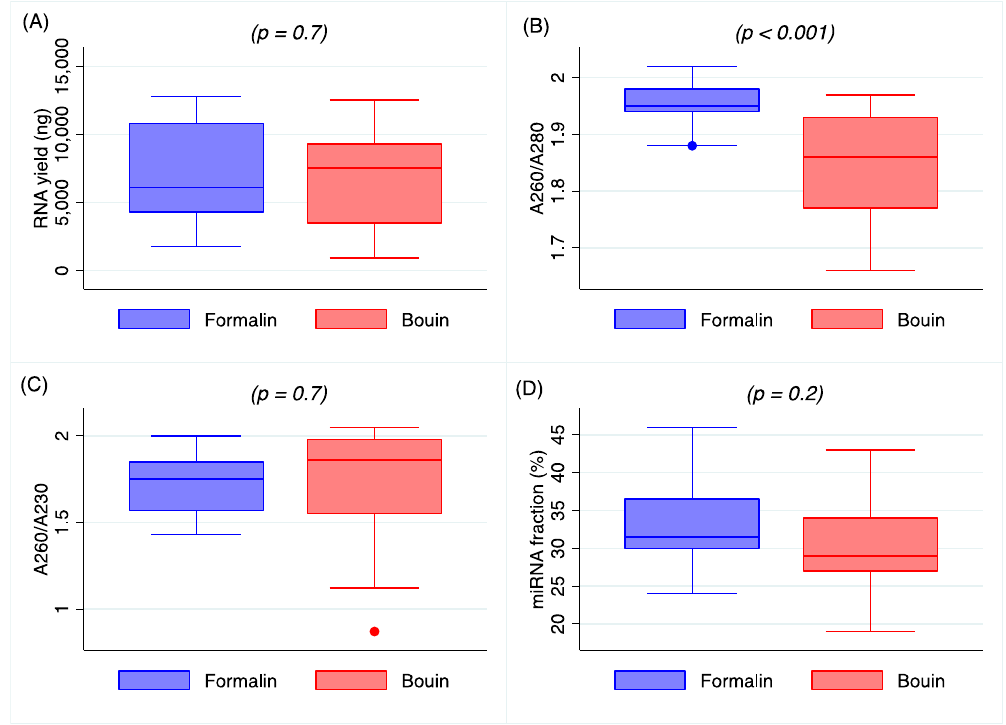
Figure 1. Box plot representing total RNA yield ( A ), RNA purity by A260/280 ratio ( B ), by A260/230 ratio ( C ), and isolated miRNA fraction ( D ) in matched formalin- and Bouin’s-fixed samples.